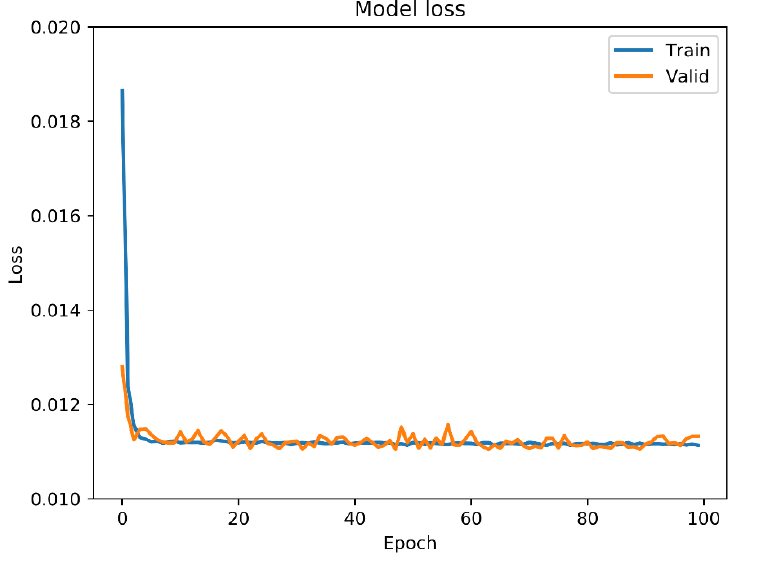
Figure 5. The same as Figure 4 but for the two-steps-ahead (2-day forecast) prediction of LSTM.